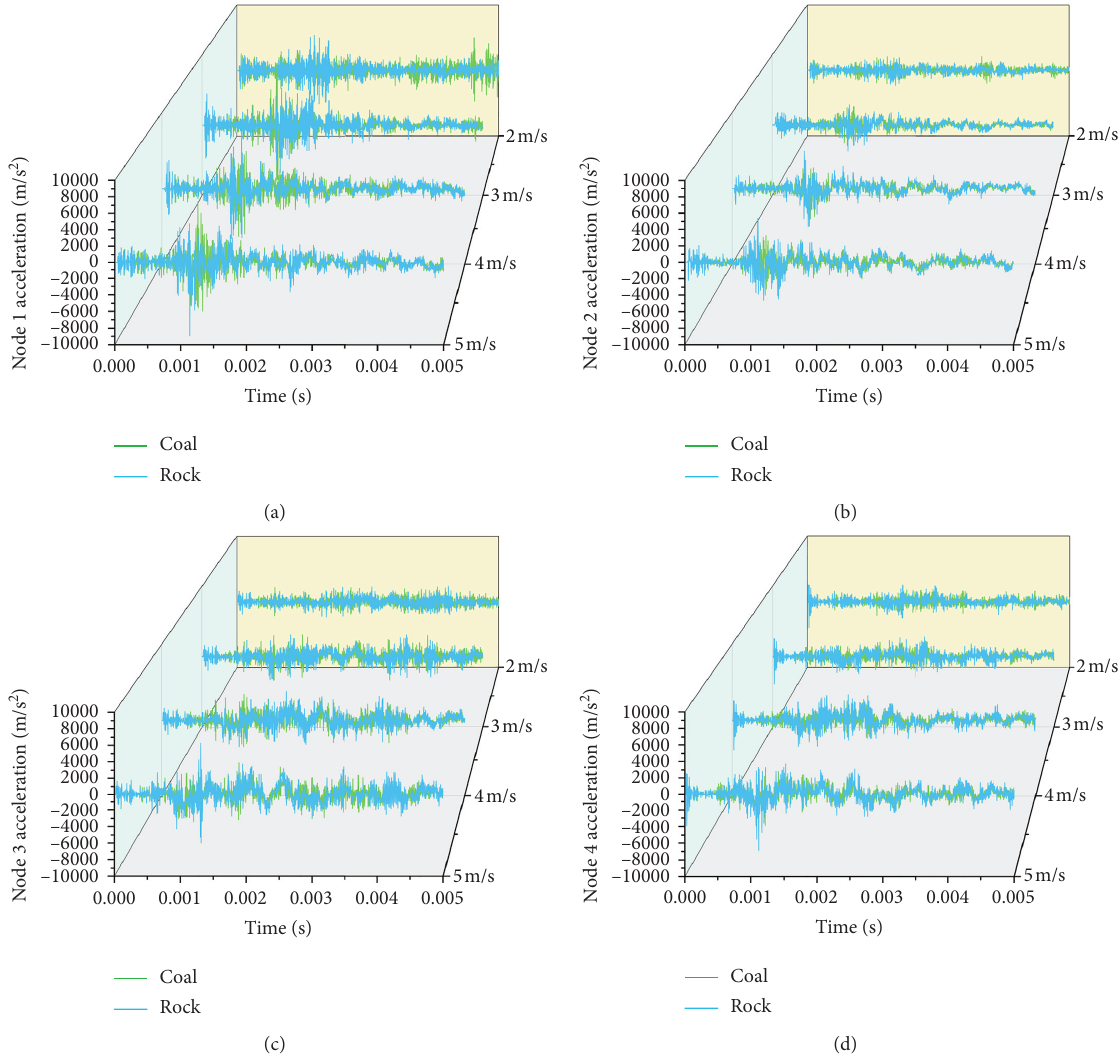
Figure 14: Nodal acceleration in the tail beam noncollision contact zone under different impact speeds: (a) Node 1 acceleration; (b) Node 2 acceleration; (c) Node 3 acceleration; (d) Node 4